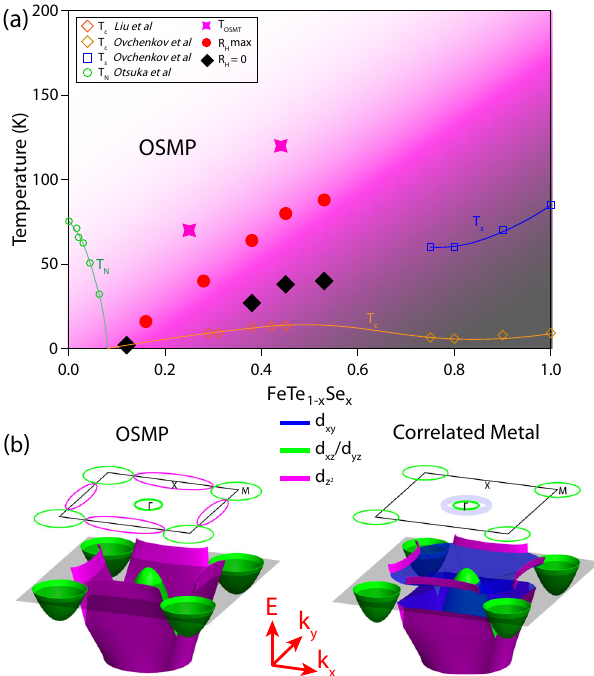
Fig. 5 Phase diagram of FeTe 1 − x Se x . a T N 69 , T s 78 and T c 46,78 represent the bi-collinear spin-density wave transition, tetragonal to orthorhombic structural transition, and superconducting transition adapted from previous reports. The temperatures for Hall resistivity ( R H ) maximum positions and R = 0 are extracted from the Hall resistivity measurements 67 . T H temperature at which the photoemission spectral weight of d xy orbital is observed to vanish (Supplementary Note 5). OSMT represents orbital- selective Mott transition. The background with gradient color suggests the orbital-selective Mott phase (OSMP) crossover. b Schematics showing the key features of the band structure of FeTe 1 − x Se x in the OSMP and correlated metal phase respectively. The disappearance of band hybridization due to the complete incoherence of d xy orbital is responsible for the Fermi surface